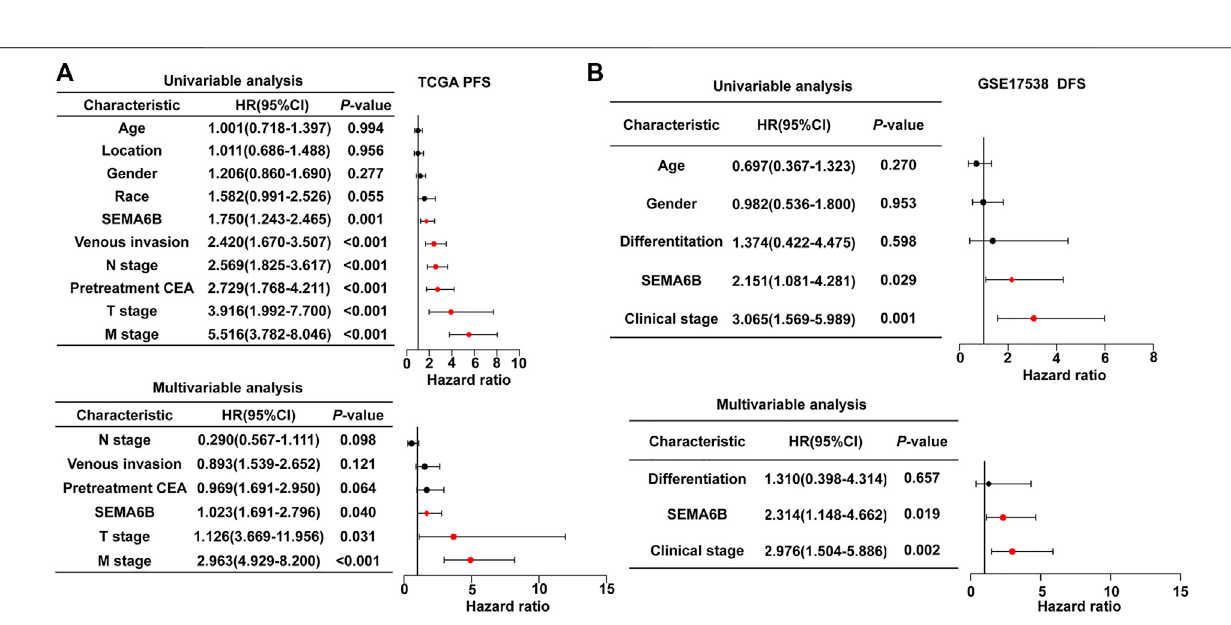
FIGURE 4 | Univariate and multivariate Cox regression analyses to evaluate the prognostic value of the SEAM6B in CRC patients. (A) PFS for TGGA dataset. (B) DFSforGSE17538dataset.Forestplotsvisualizingthehazardratios(HRs)and95%con fi denceintervals(CI)foreachvariable.Differenceswith p < 0.05wereconsidered signi fi